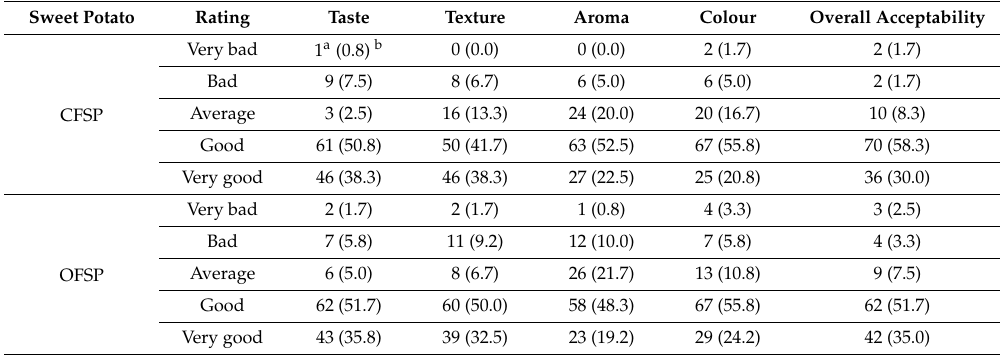
Table 5. Number and percentages of panellists who gave the di ff erent ratings for the sensory attributes evaluated ( n =